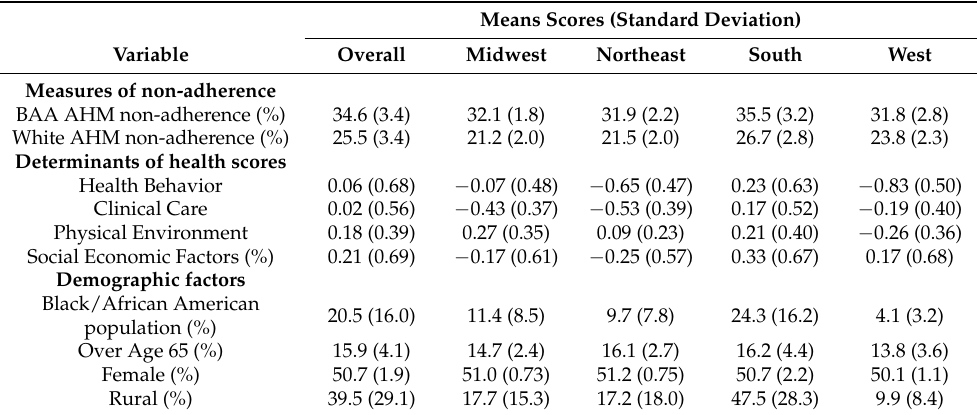
Table 1. Mean and standard deviations of variables included as covariates in the model by region among 875 counties in the U.S.